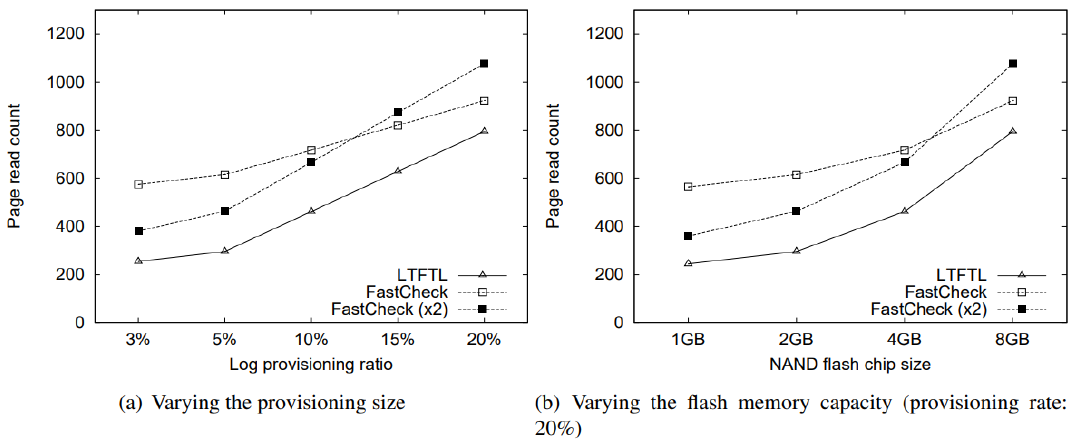
Figure 8. Recovery time cost.